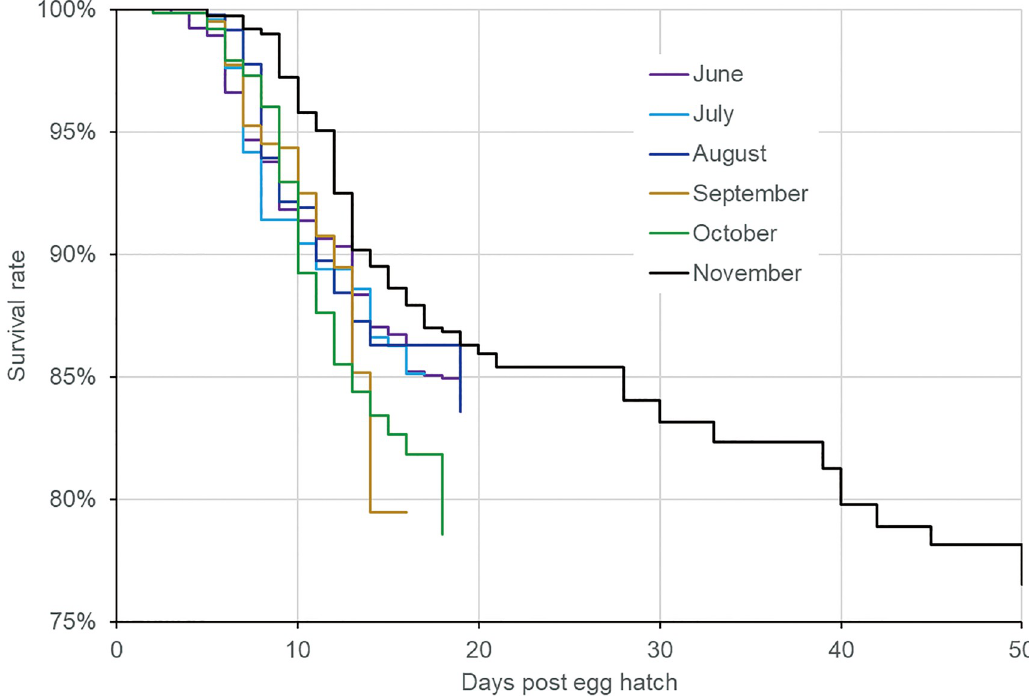
Fig 7. Stage-specific development time of Ae . albopictus larvae in different months. June-July experiments were conducted in semi-natural condition and August-November experiments were conducted in semi-field condition.